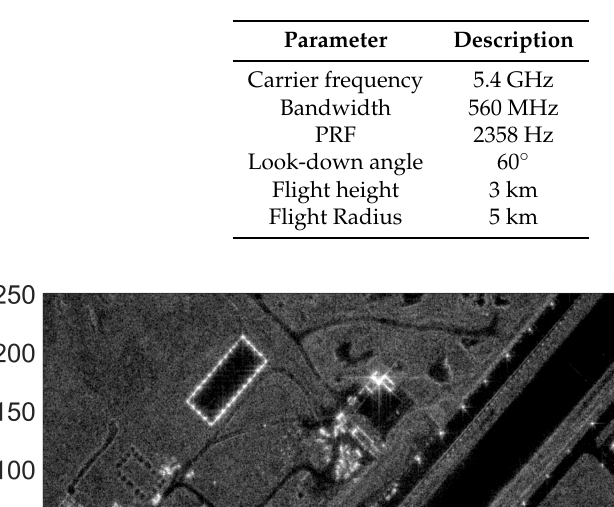
Table 2. Parameters of the C-band circular SAR experiment.